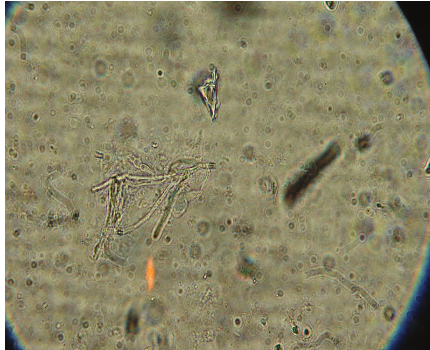
Figure 2: 10% KOH mount shows hyaline septate hyphae. (Magni- fication